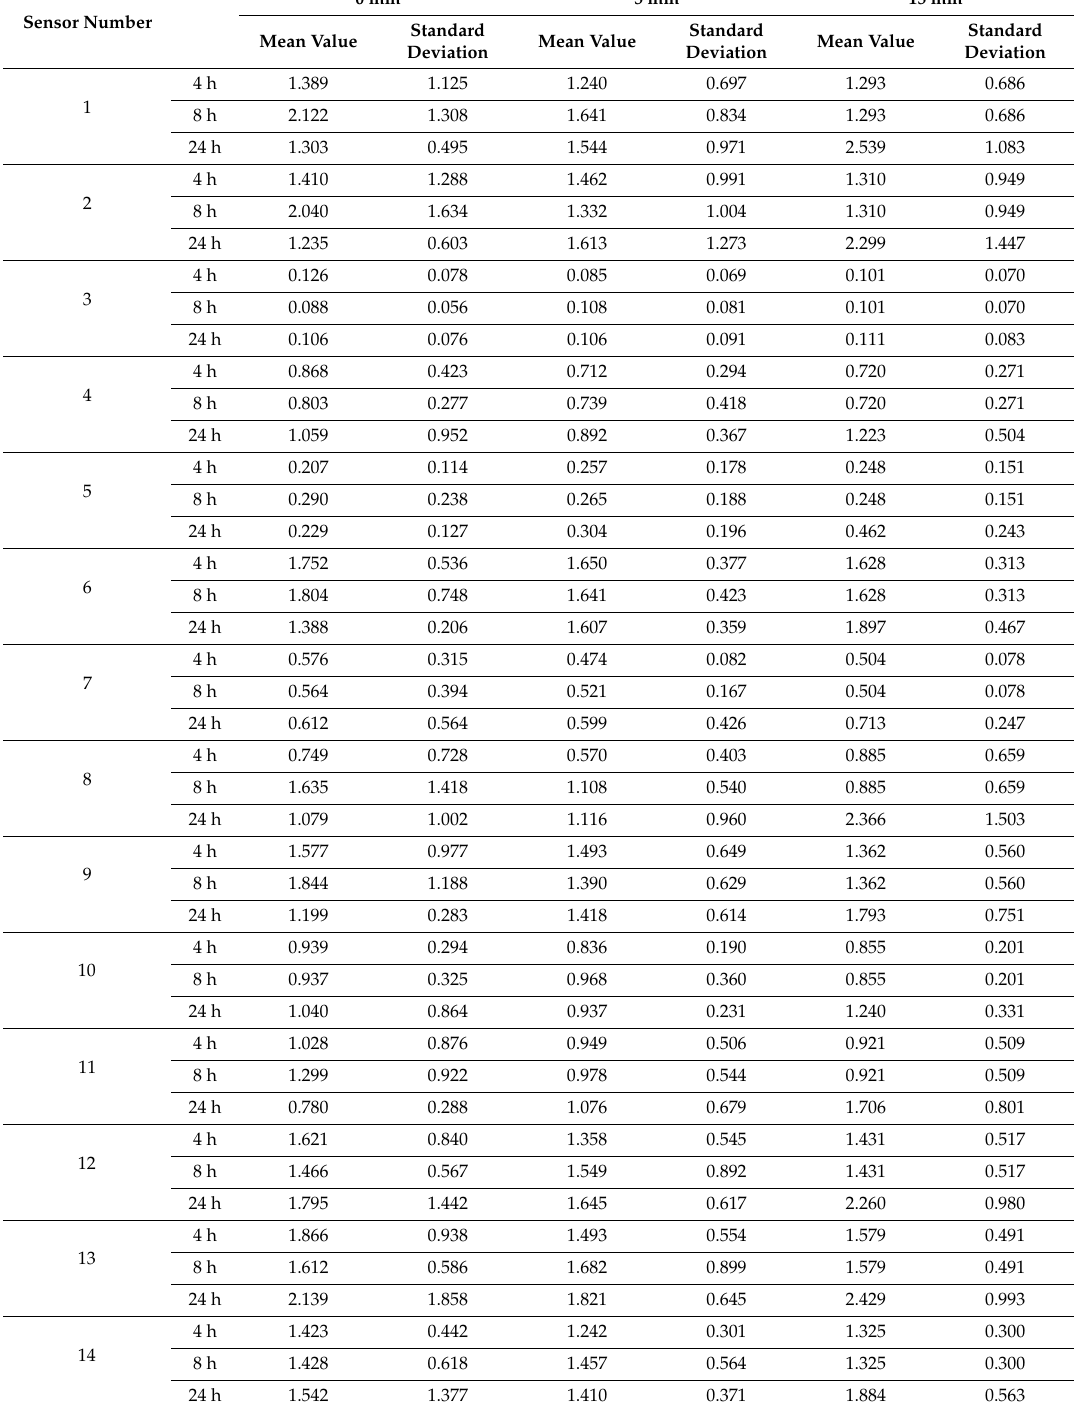
Table 2. Mean values and standard deviations of electronic nose (e-nose) responses of yellow peach from three groups at 4, 8, and 24 h after the fruit was compressed. Fruits without compression damage were in Group 0. Fruits compressed by 5 mm were in Group I. Fruits compressed by 15 mm were in Group